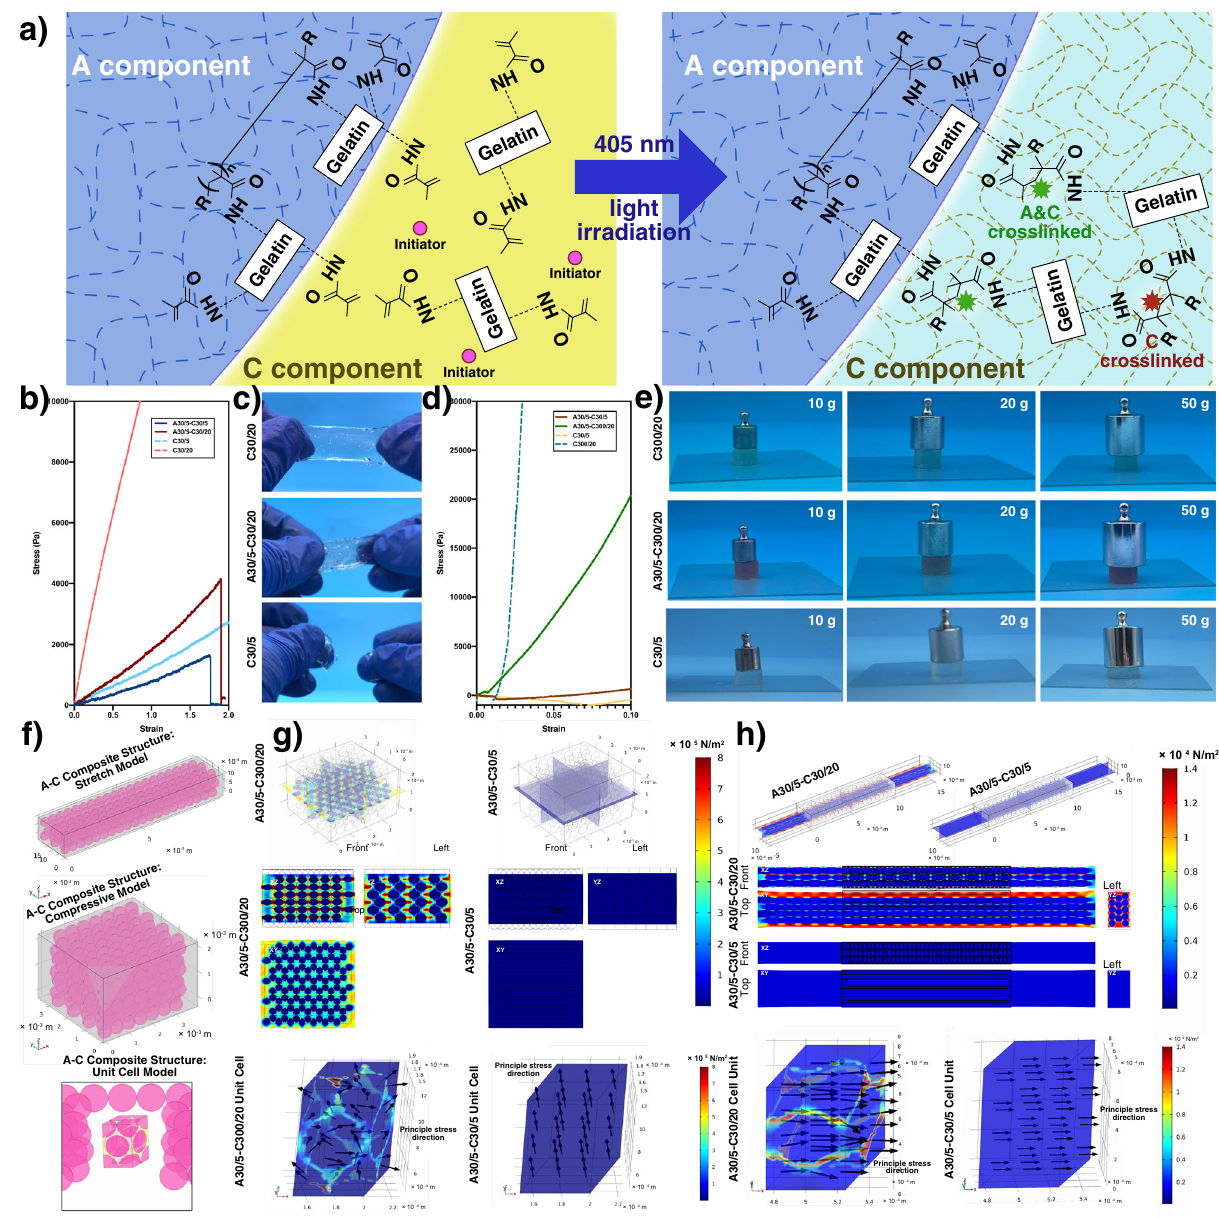
Fig. 5 Mechanical properties of A – C composite structure. a Mechanism of the stable covalent bonds forming process of A – C composite structure. b Tensile testing curve. c Tensile state of different bioink. d Compressive testing curve. e Compressive state of different bioink. f Simulation models of tensile/ compressive A – C composite structure and unit cell. g Compressive simulation of A – C composite structure. h Tensile simulation of A – C composite